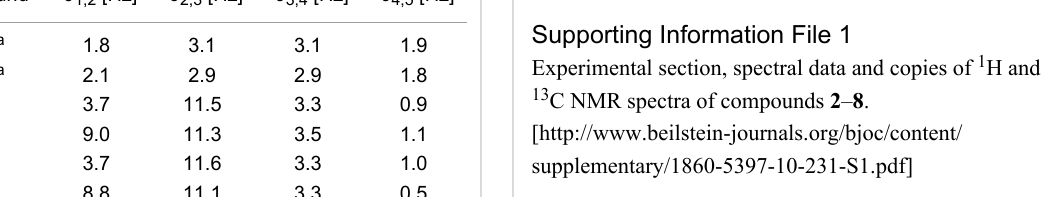
Table 2: Characteristic coupling constants of compounds 7a–c .